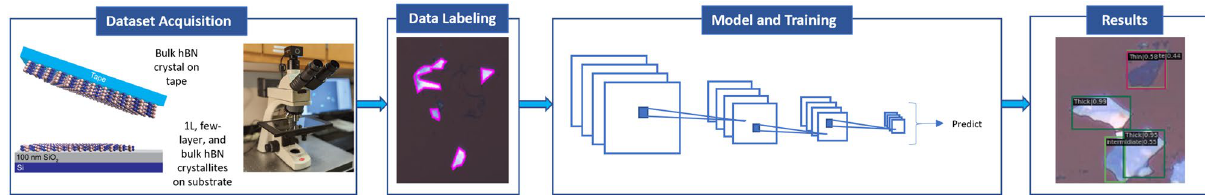
Figure 1. Proposed deep learning pipeline for 2D flake detection. First, a dataset of hBN samples are collected through mechanical exfoliation. Then as the second step, the dataset is annotated manually using an online annotation tool. During the third step, DetectoRS is chosen as the training algorithm, and for the last step, the trained model is applied to the test images to detect hBN